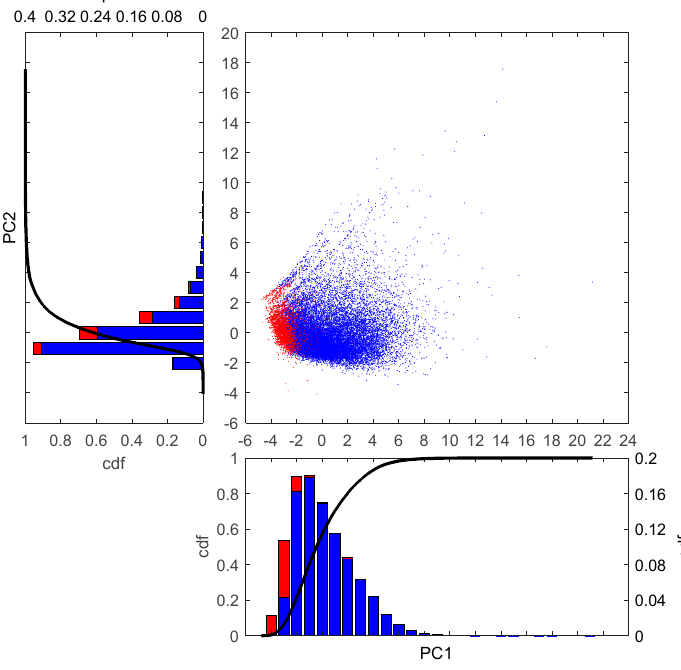
Figure 9. Scatter-plot of the two first principal components—coloring according to the constraint: blue: U-constrained feeders/red: I-constrained feeders.